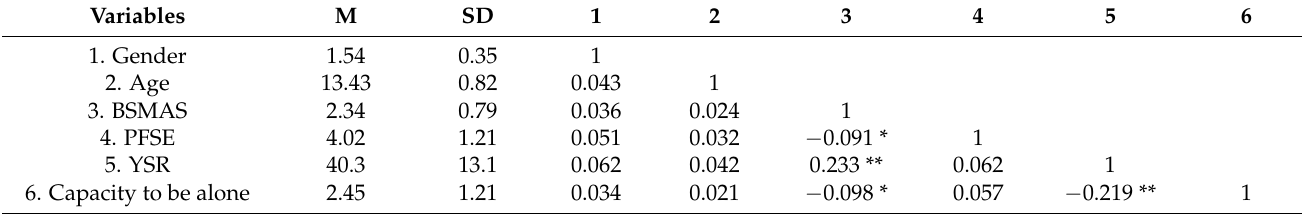
Table 1. Descriptive statistics and correlations among all of the study